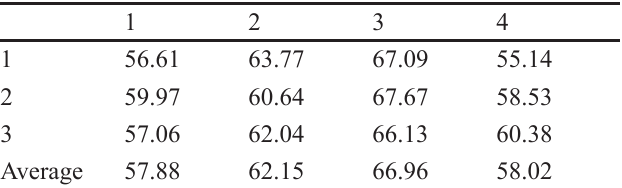
TABLE IV - Paracetamol content (%), considering the theoretical drug value (70%) added to formulations containing PVP (1), PEG (2), HPMC (3) and MC